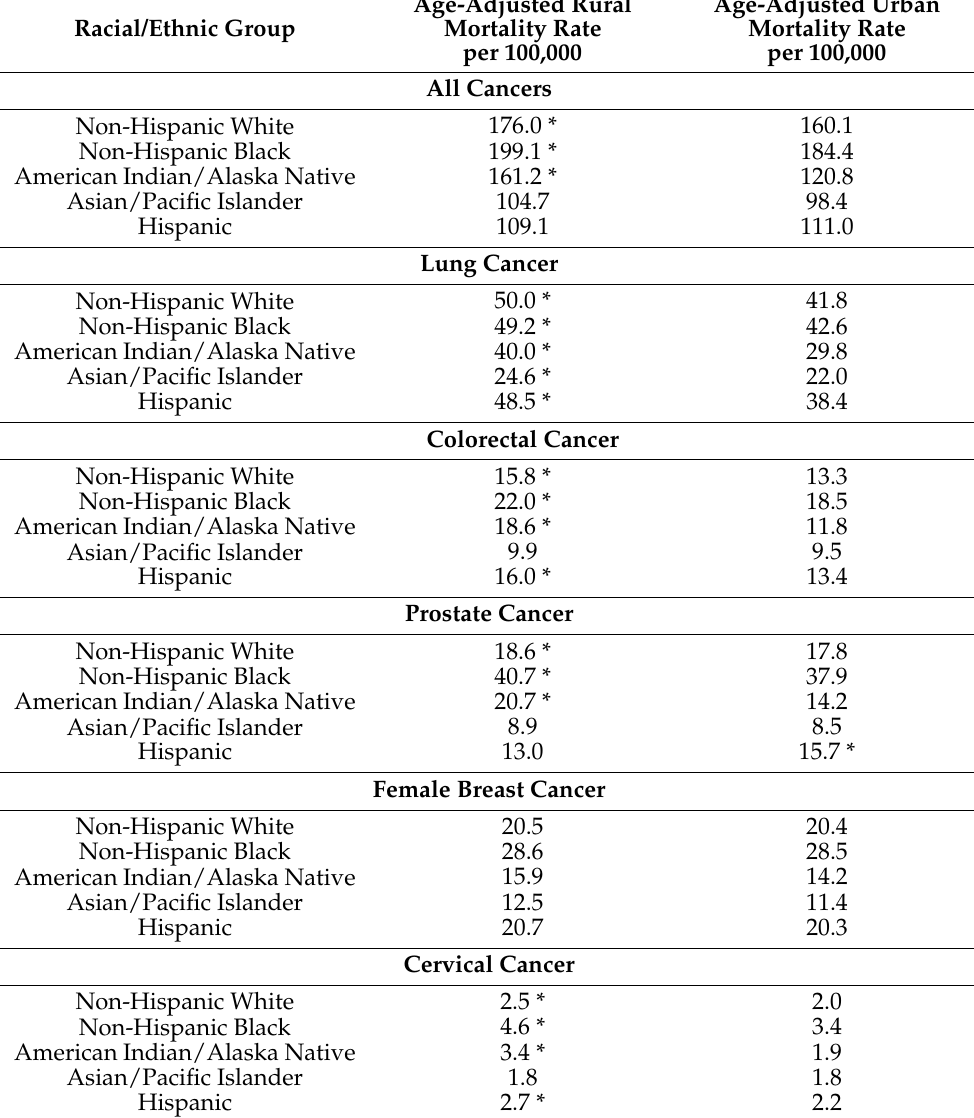
Table 2. Rural and urban age-adjusted cancer mortality rates across racial/ethnic groups,